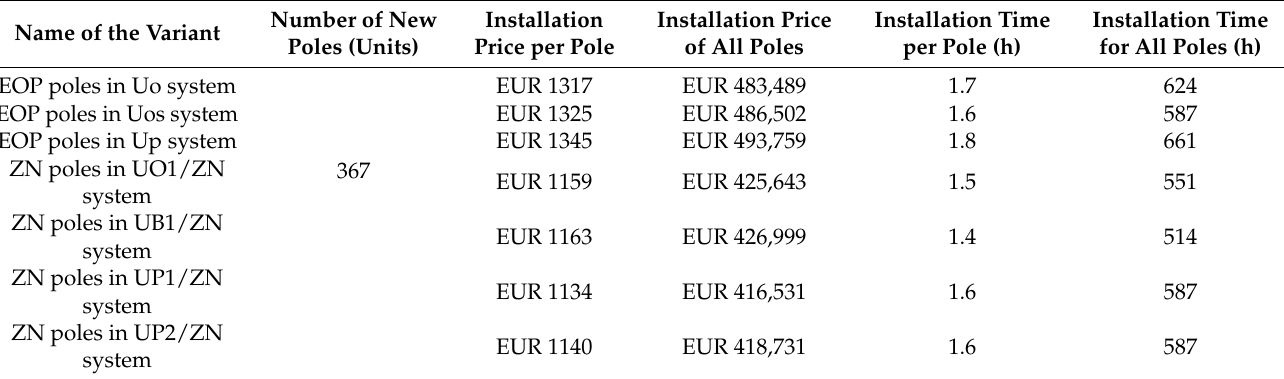
Table 4. Pole installation costs for the 7 selected options.